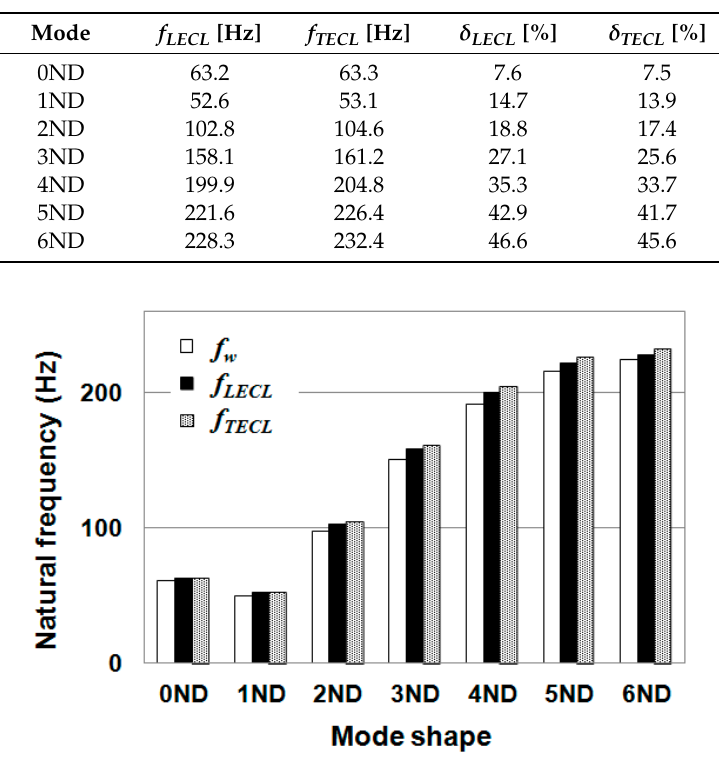
Figure 16. Natural frequencies of the runner with pure water and with different cavities.